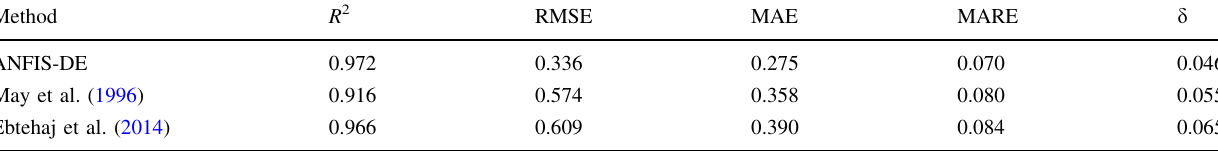
Table 3 Comparison of ANFIS-DE and existing regression-based equations (all data)